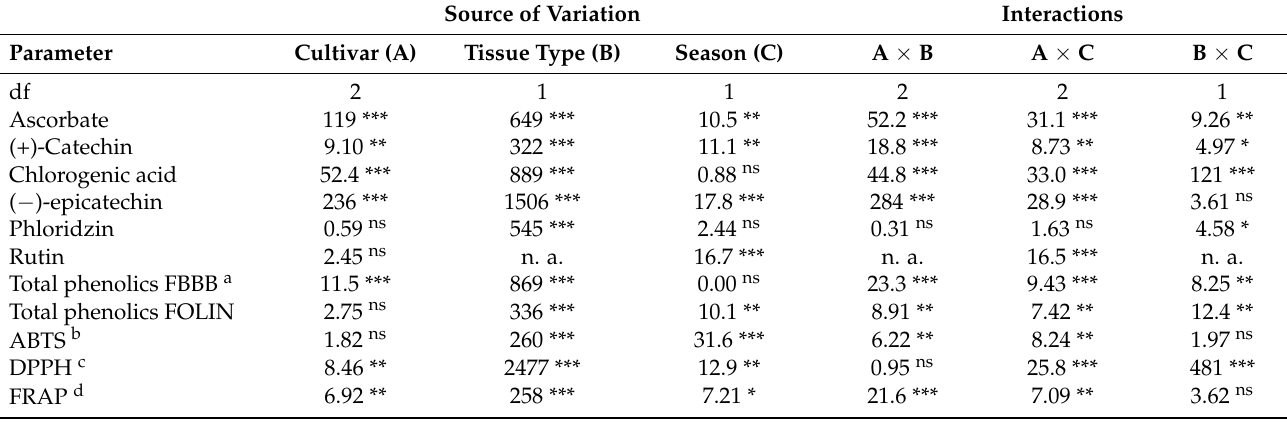
Table 1. Summary of statistics (test ANOVA) for analysed parameters; F values for particular sources of variation and the level of their